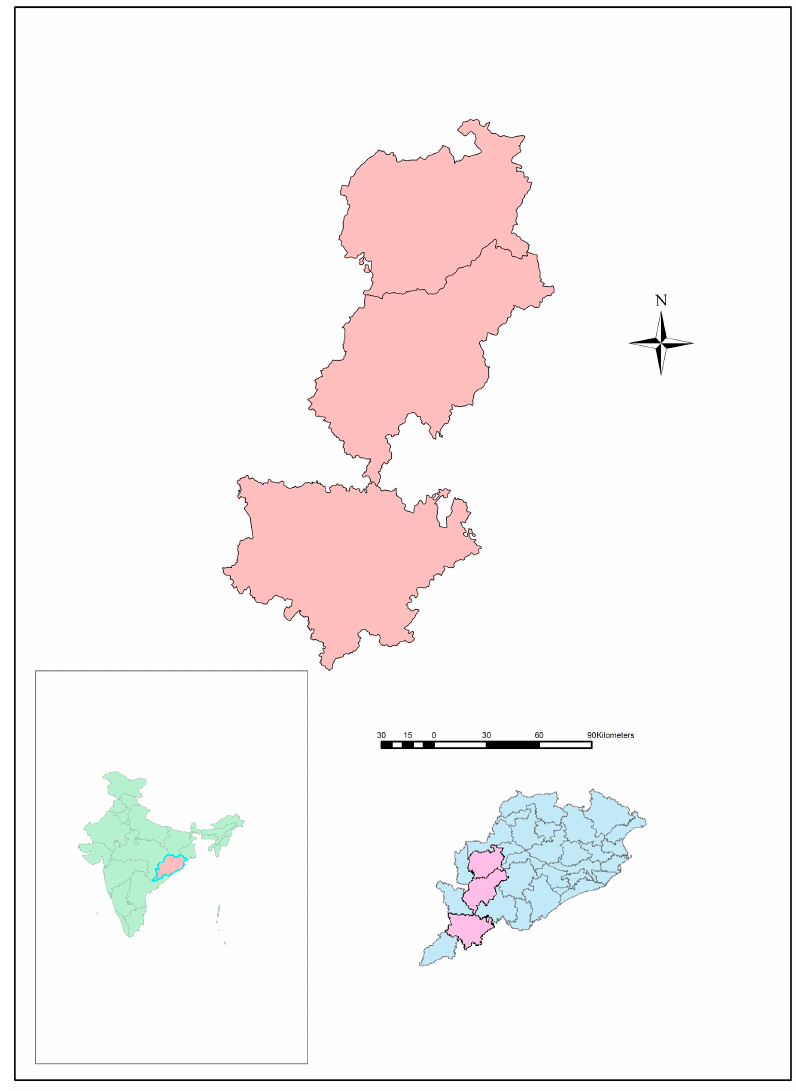
Figure 1. Location map of Kalahandi, Bolangir and, Koraput (KBK) districts.